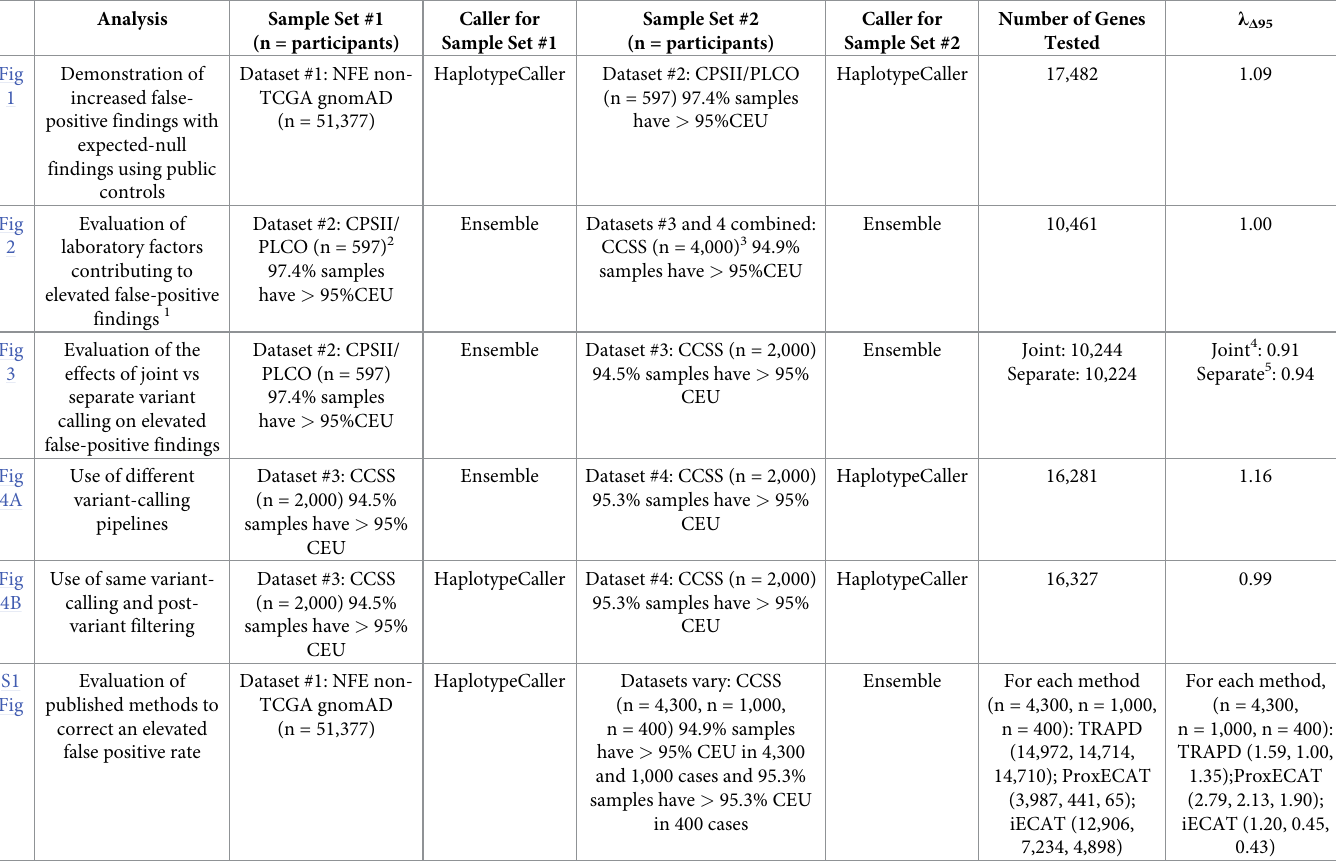
Table 1. Summary of data